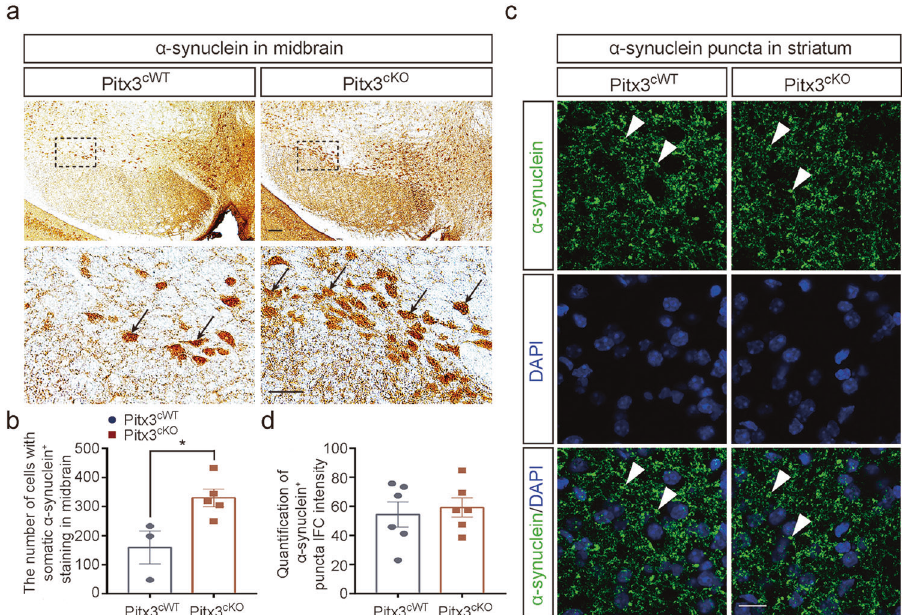
Fig. 7 The increasing number of neurons with somatic accumulation of α -syn in 15-month-old Pitx3 cKO mice. a IHC staining of α -syn in the ventral midbrain from 15-month-old Pitx3 cWT and Pitx3 cKO mice (scale bar: 100 μ m; high-magni fi cation, 50 μ m). b Quanti fi cation of α -syn + cells in the ventral midbrain from 15-month-old Pitx3 cWT and Pitx3 cKO mice ( N = 3 – 4 mice per genotype). Mann – Whitney test, * p = 0.0357. c IFC staining of α -syn in the striatum from 15-month-old Pitx3 cWT and Pitx3 cKO mice (scale bar: 10 μ m). d Quanti fi cation of α -syn + puncta IFC intensity in the striatum from 15-month-old Pitx3 cWT and Pitx3 cKO mice ( N = 6 mice per